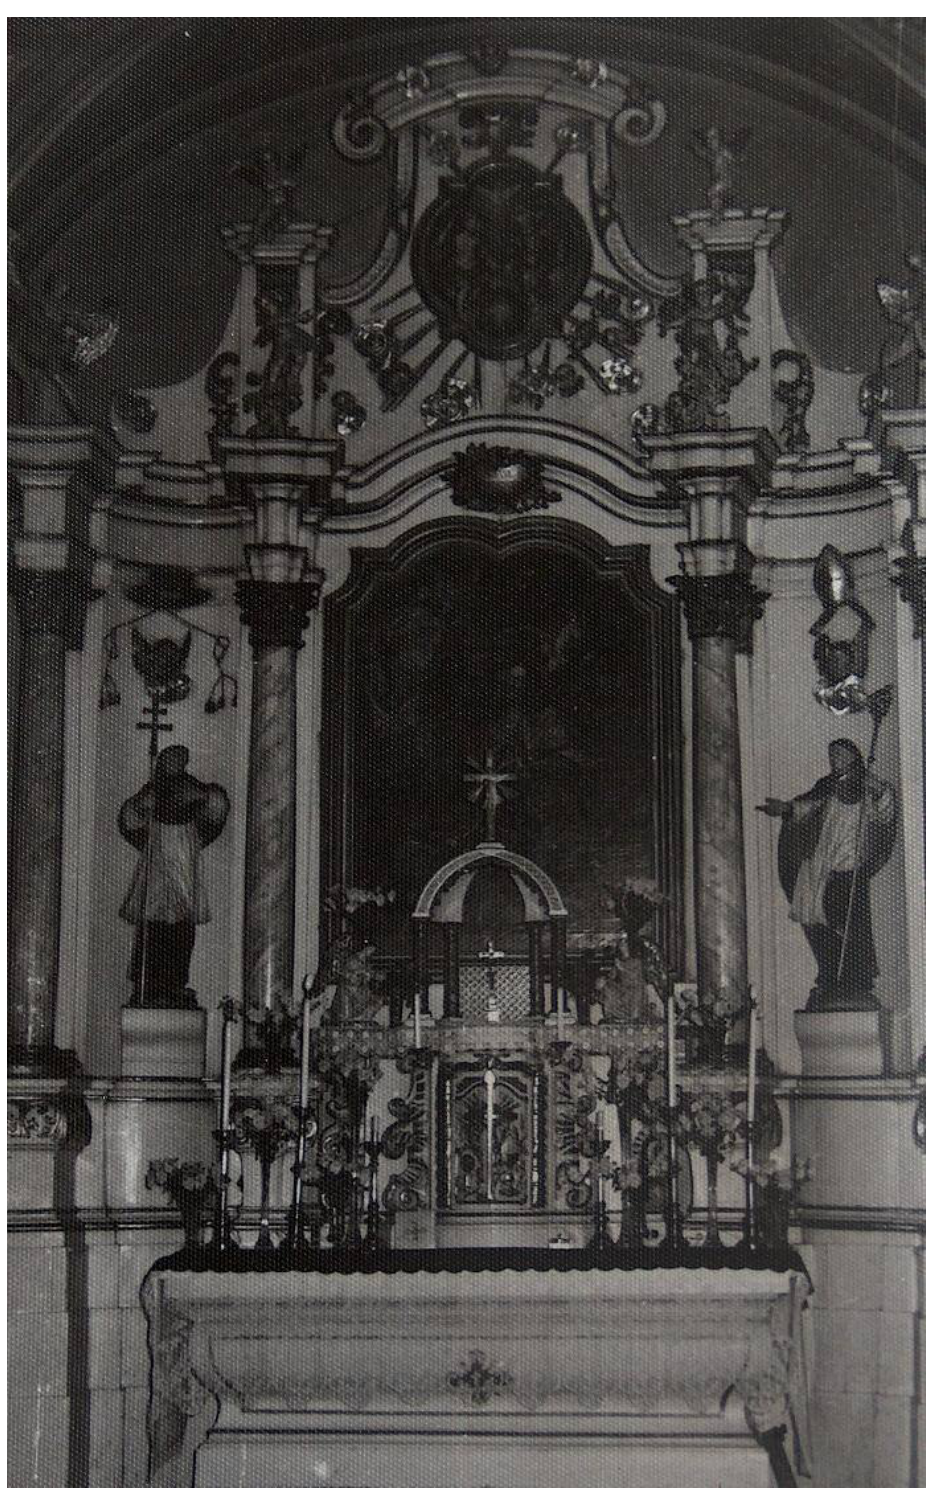
Figure 6. Period Image of the Altar of the Franciscan Catholic Church.